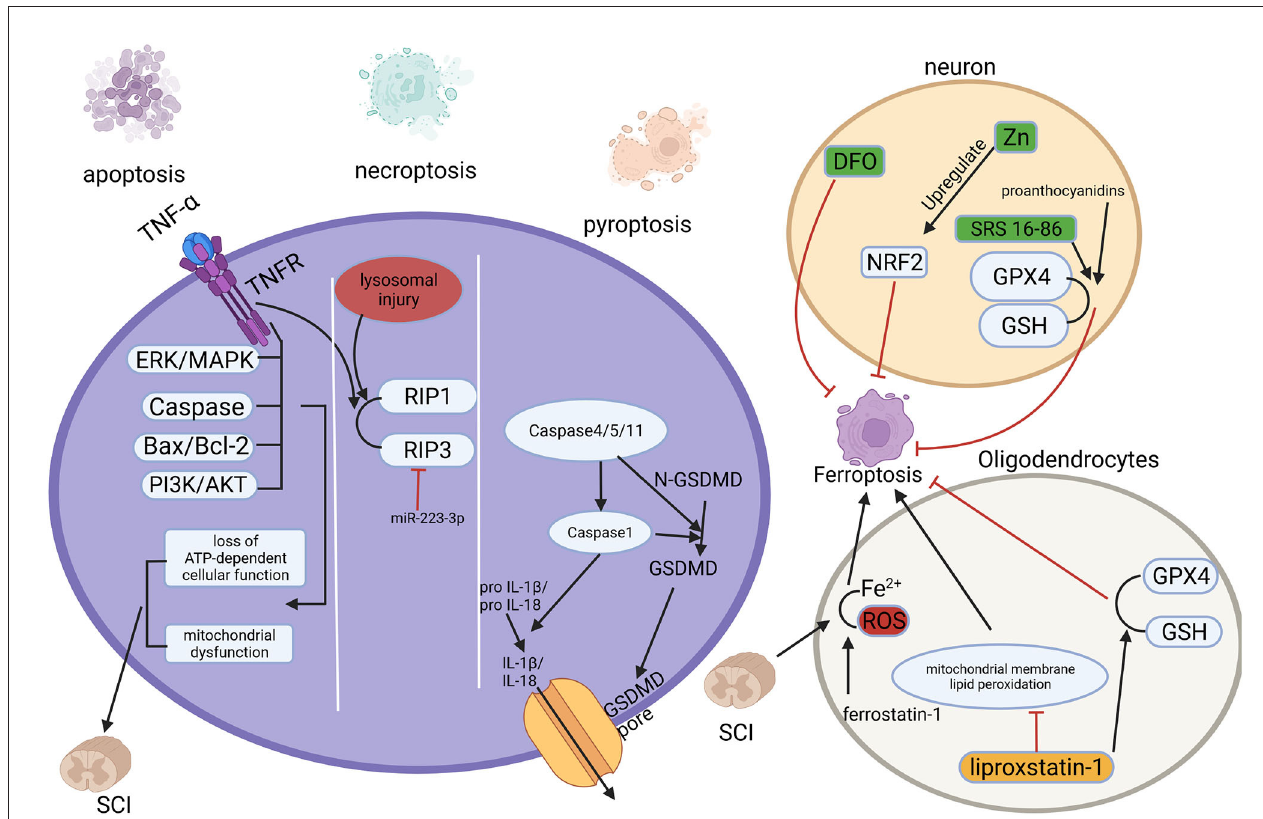
FIGURE 2 | Multiple regulated cell deaths (RCDs) play a role in spinal cord injury (SCI). RCD, regulated cell death; SCI, spinal cord